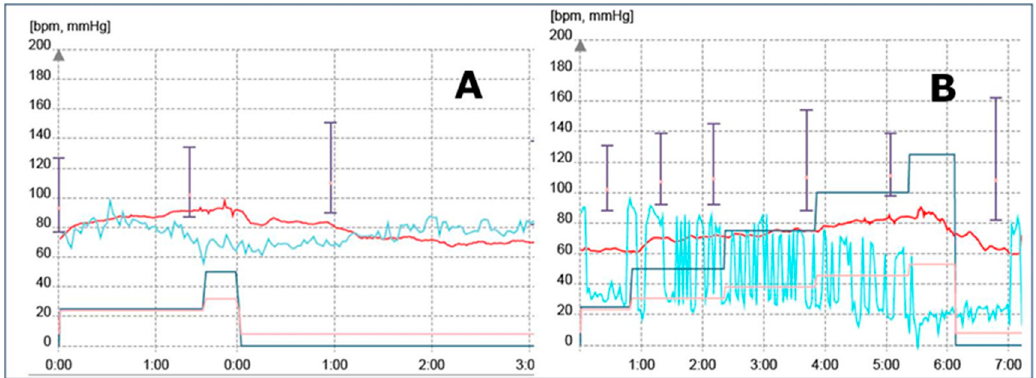
Figure 4. HR diagram (red line) in a patient with chronotropic incompetence ( A ) and redone ET after reprogramming rate–response function ( B ).